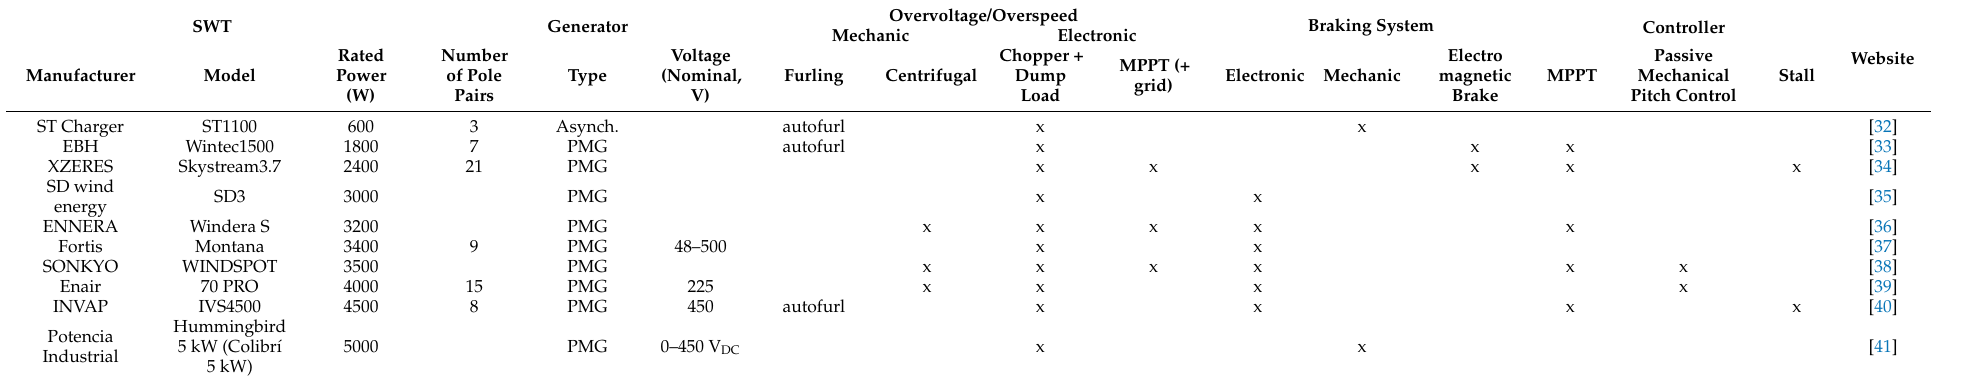
Table 2. Short list of grid-connected SWTs in the low power range and their main